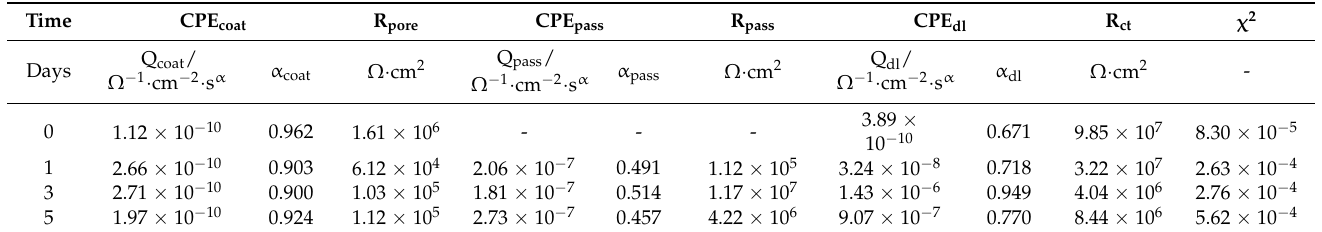
Table 5. Fitted values of EEC components, ZP 2% in PB (ZP–02%-PB).